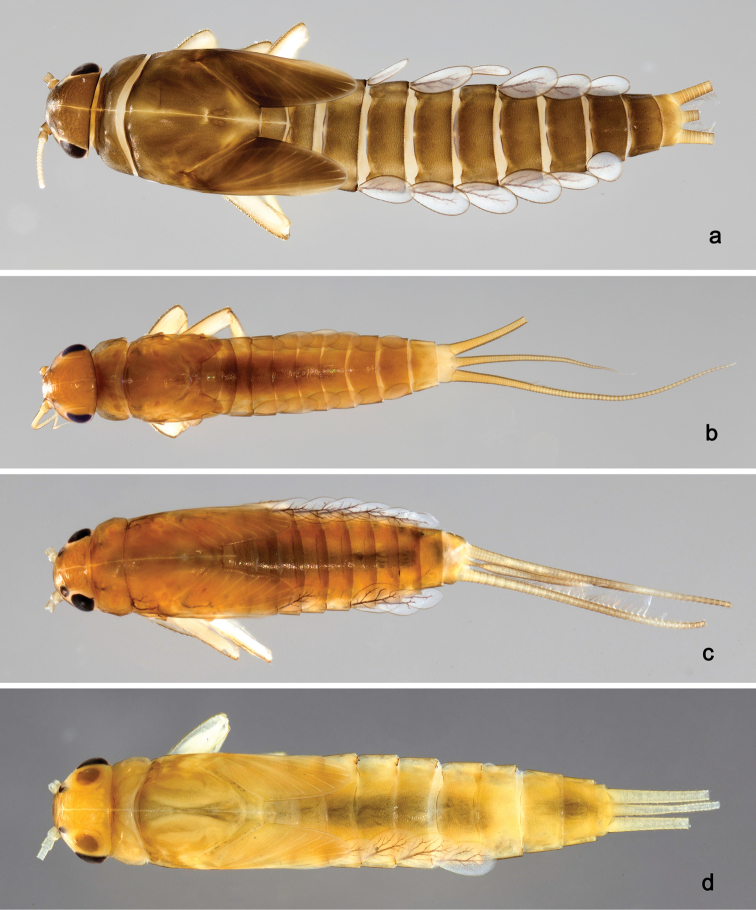
Habitus, larvae: aLabiobaetisbranchiaesetis sp. n., dorsal view bLabiobaetismagnovaldus sp. n., dorsal view cLabiobaetisplanus sp. n., dorsal view dLabiobaetispodolakae sp. n., dorsal view.